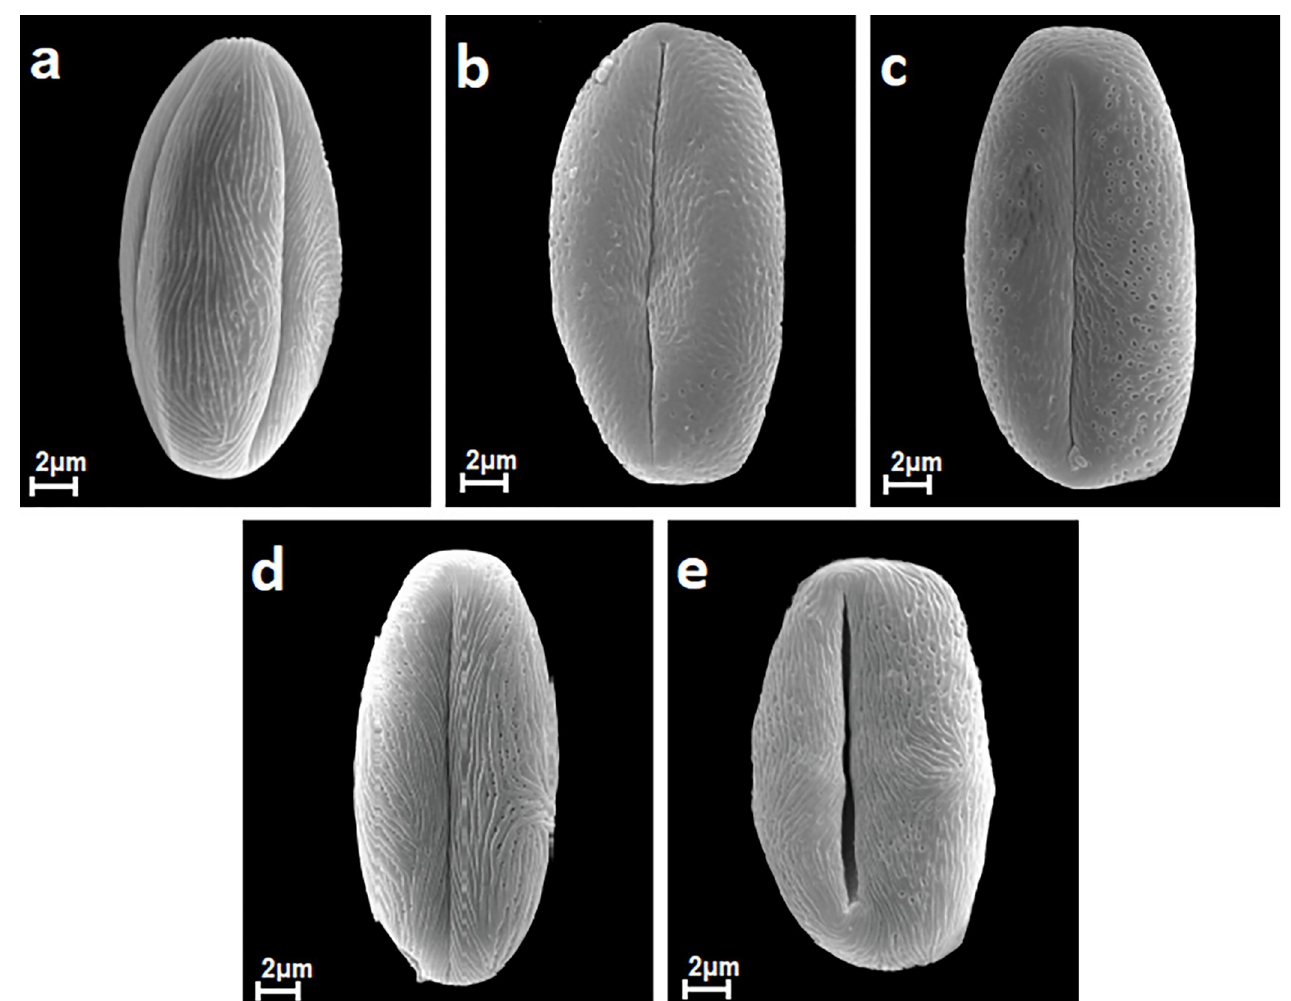
Fig 2. Pollen grains in equatorial view in S . cana , S . henryi , S . salicifolia , S . trichocarpa , S . veitchii , A-E.